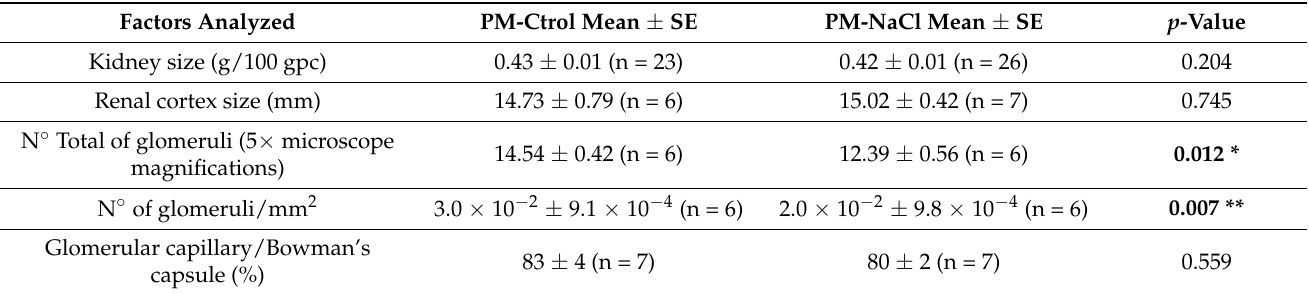
Table 2. Size and basal histological values of PM-Ctrol and PM-NaCl kidneys.